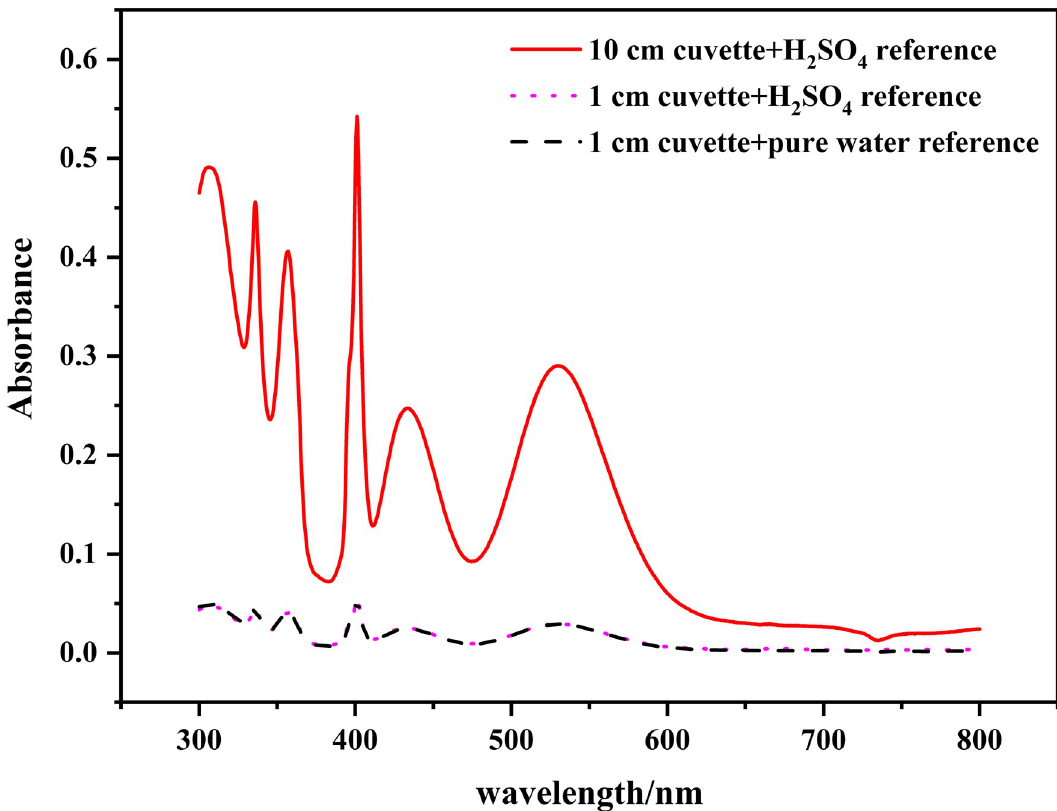
Fig 1. Spectra of a MnSO 4 solution measured with different cuvettes and